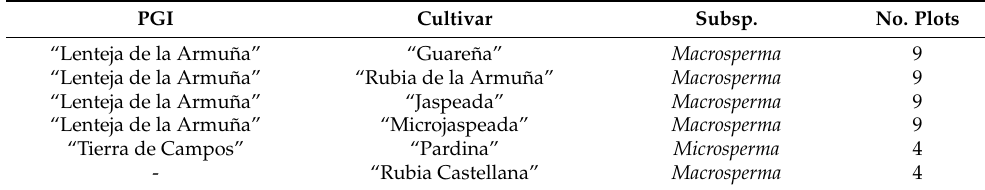
Table 3. Identification of the studied cultivar and number of experimental plots